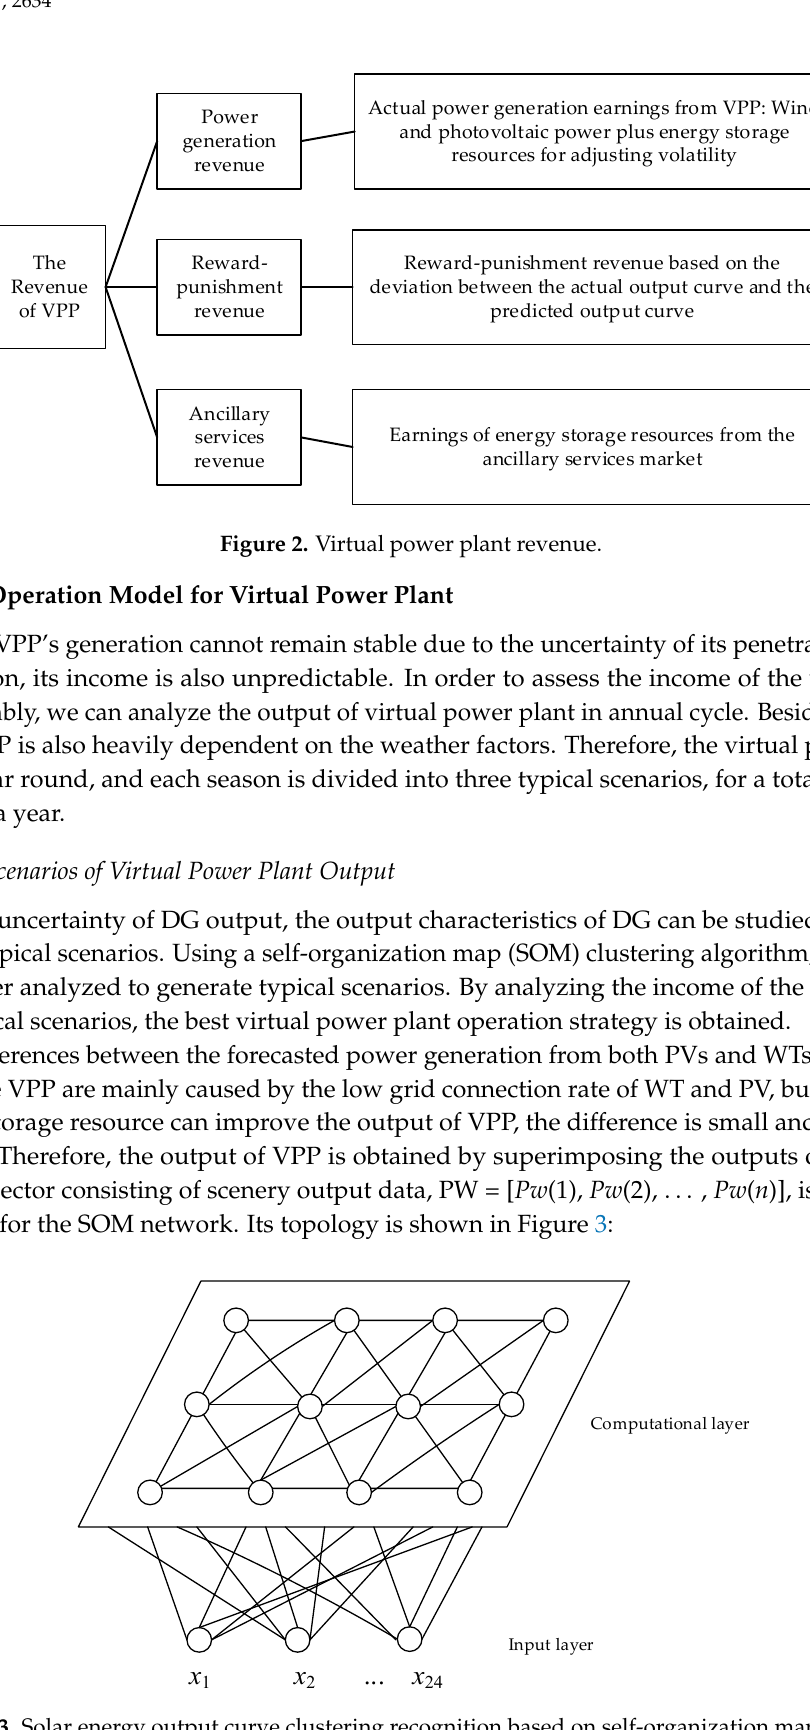
Figure 3. Solar energy output curve clustering recognition based on self-organization map (SOM).